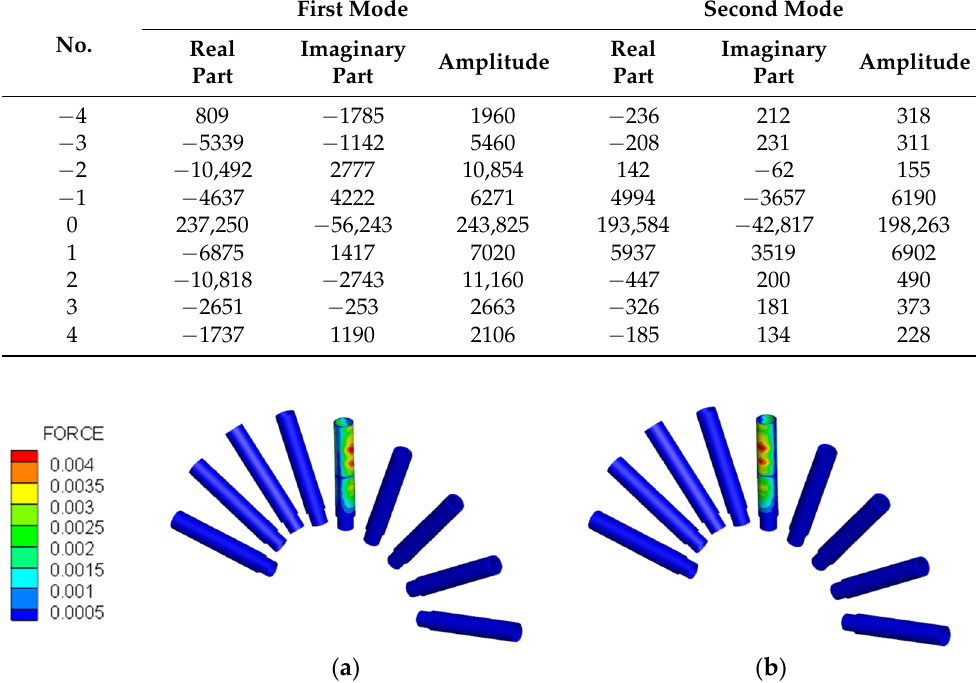
Table 4. Aerodynamic influence coefficients.